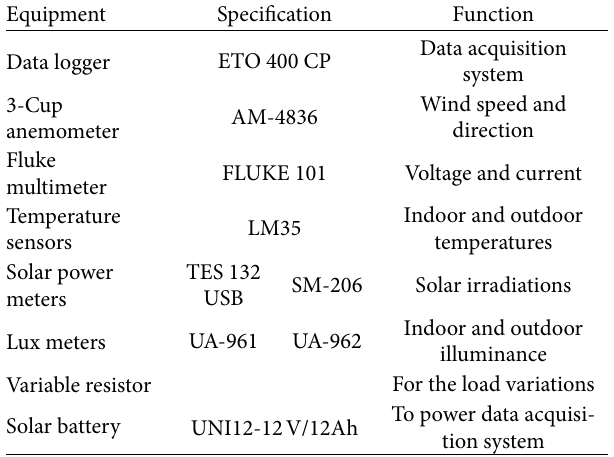
Table 1: Descriptions of measurement equipment for the study. Equipment